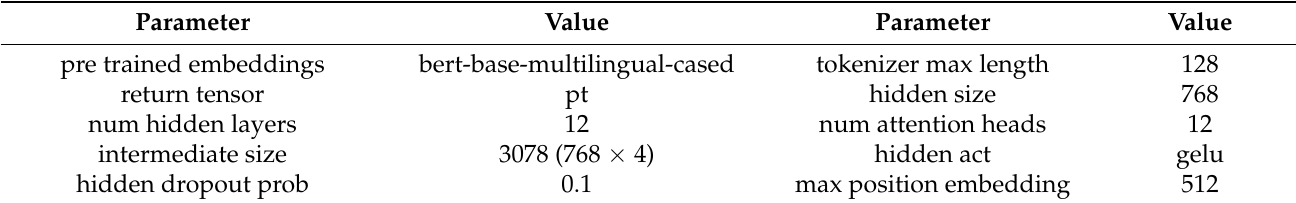
Table 4. Parameters chosen to configure the encoder architecture of Figure 4.